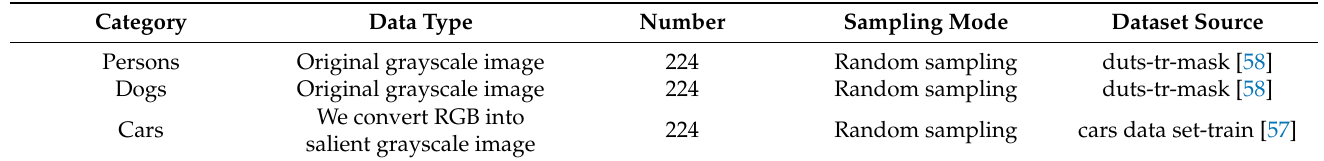
Table 1. Data information of three objects in the training set.